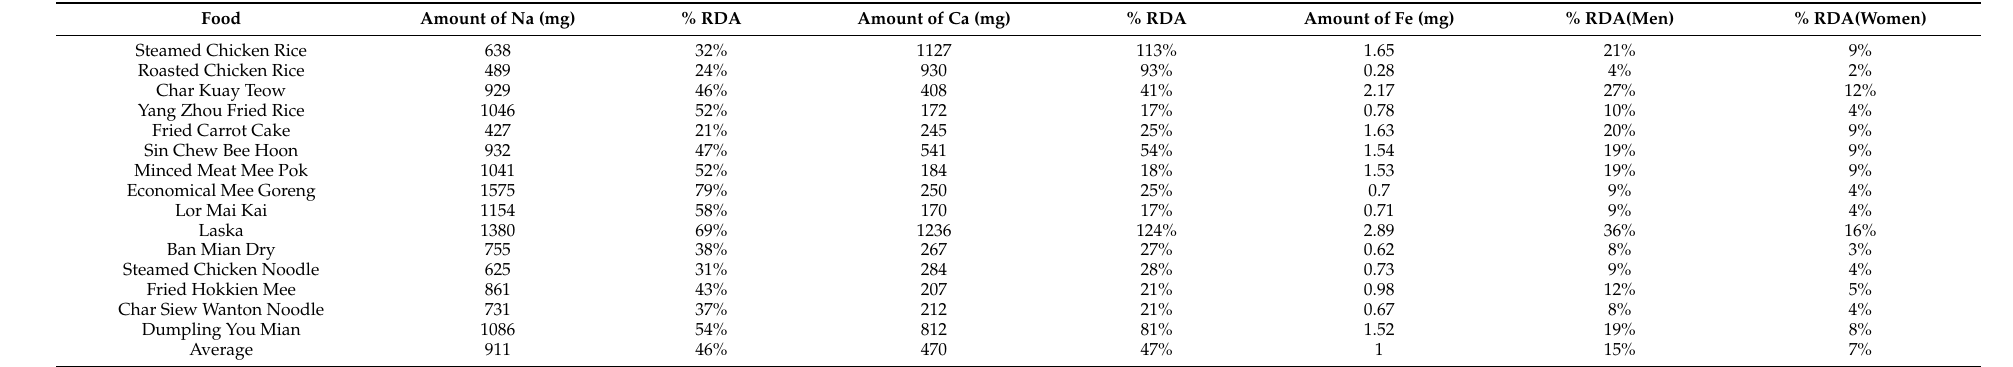
Table 7. Mineral content and the %RDA of the commonly consumed Chinese